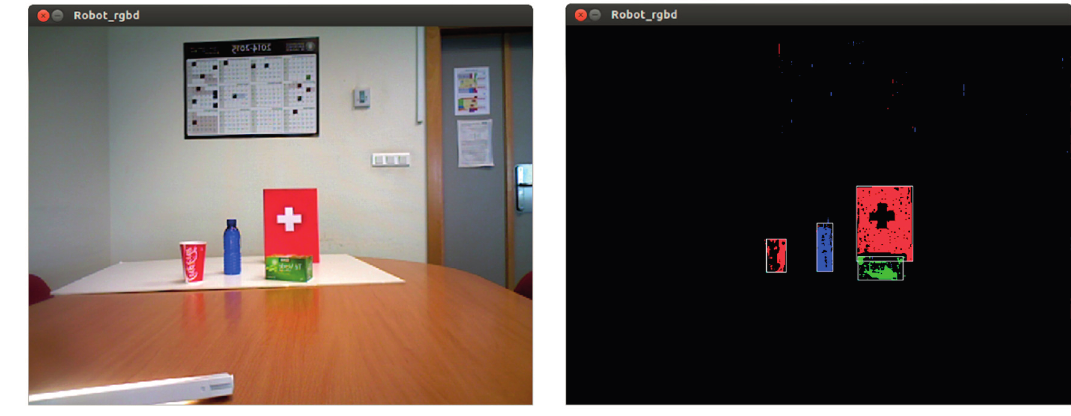
Figure 7. Elements detection.